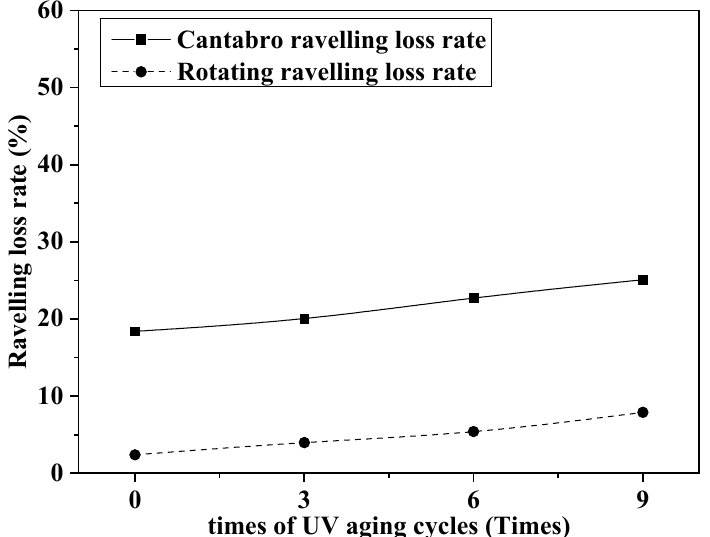
Figure 11. The results of the comparison between the two types of stripping tests under the influence of UV aging factors.